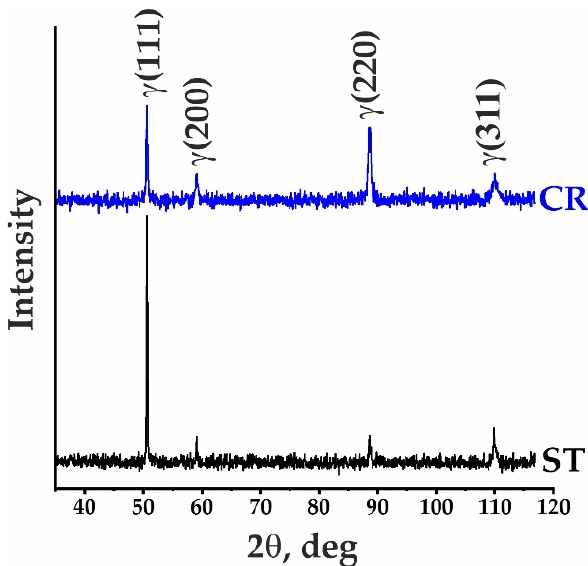
Figure 1. XRD patterns of new steel in ST and CR states.